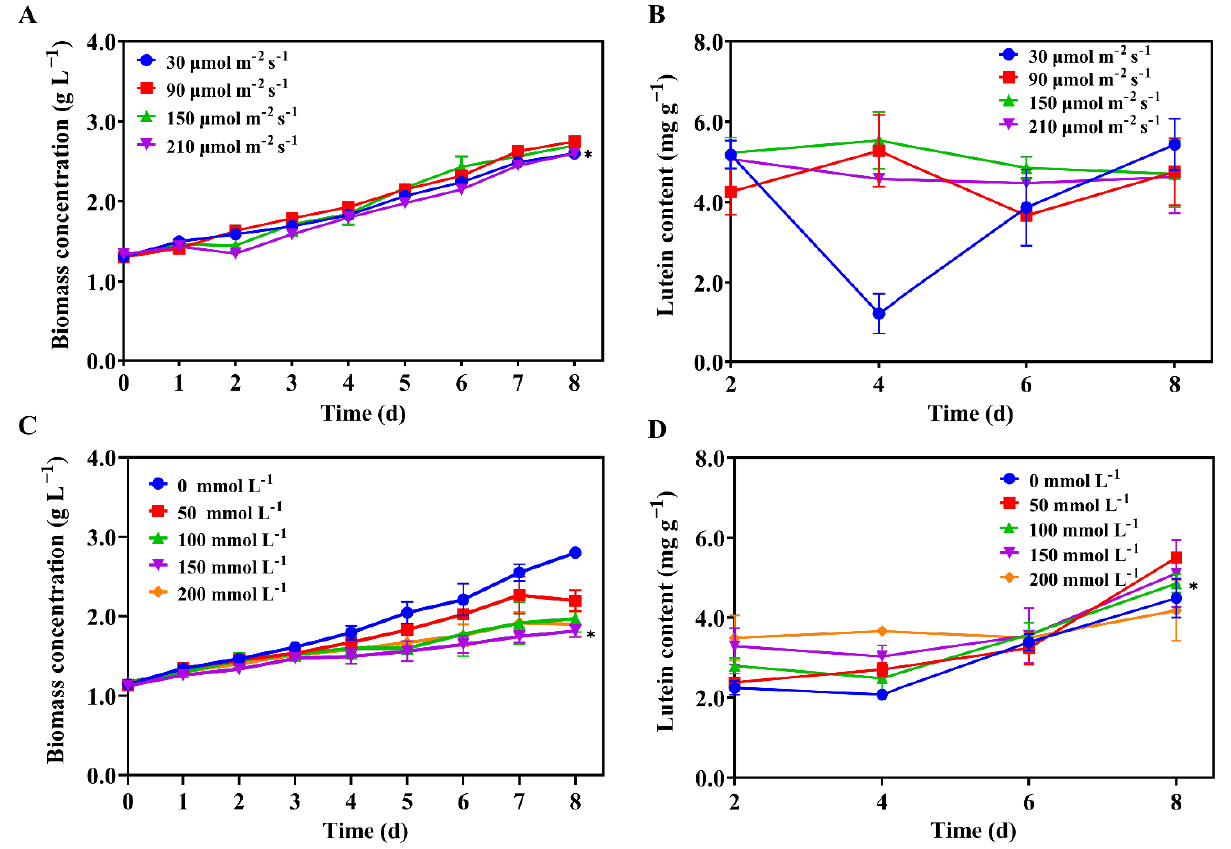
Figure 3. Effect of different light intensities and NaCl concentrations on the growth ( A , C ) and lutein content ( B , D ) of Scenedesmus sp. FSP3 in the second stage, (The 90 μmol m −2 s −1 light intensity used in the NaCl experiments . Dunnett’s test was performed to determine statistically significant difference: *, p < 0.05, n = 3)